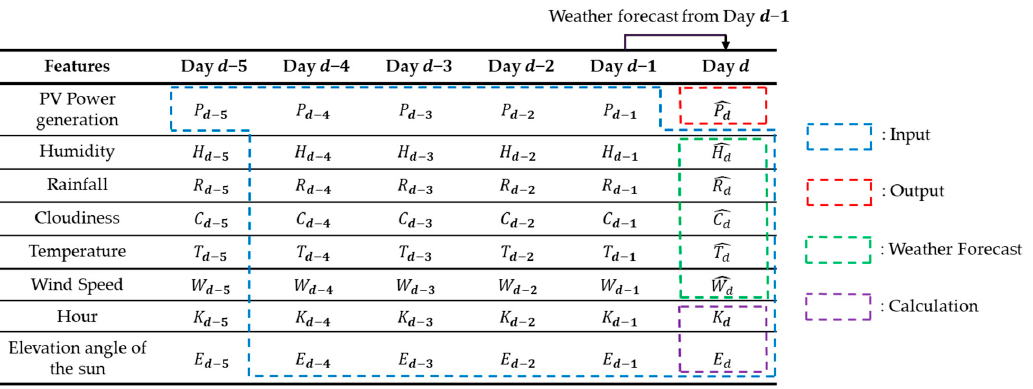
Figure 4. Inputs and outputs at the testing phase .